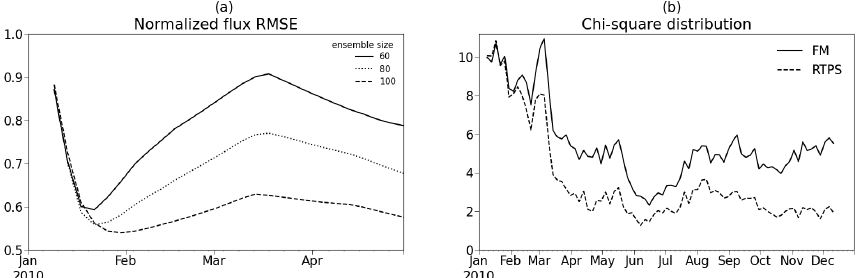
Figure 7. (a) Flux estimation RMSE using different ensemble sizes with RTPS covariance inflation. (b) χ 2 distribution using FM and RTPS covariance inflation methods, with an ensemble size of 100.